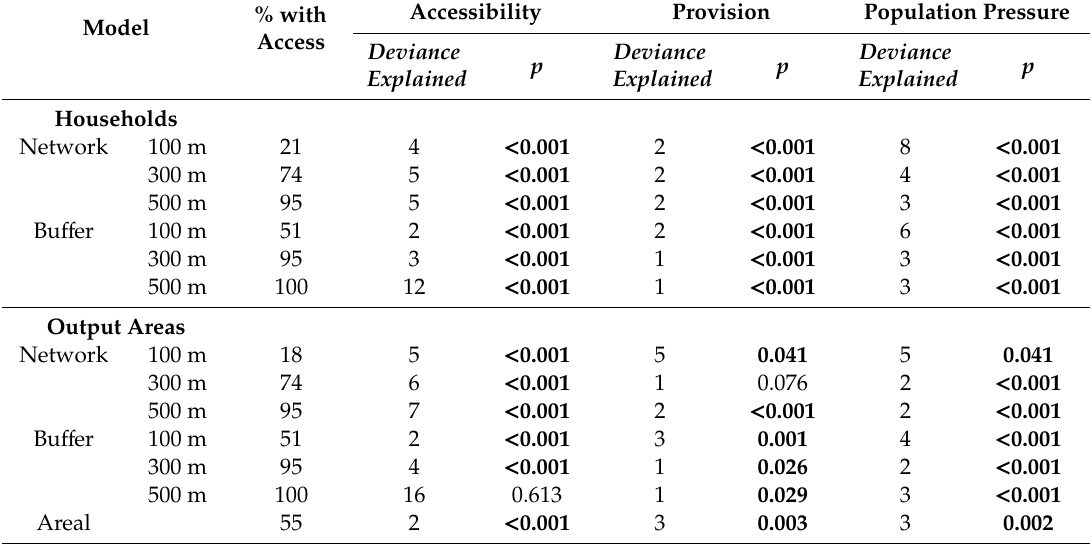
Table 1. Results of ANOVAs testing di ff erences in greenspace accessibility, and provision and population pressure for households / OAs with access to at least one greenspace, by decile of Carstairs Deprivation Index. Deviance explained shown as a percentage. Statistically significant p -values are shown in bold. Proportion of households / OAs with access shown to indicate loss of statistical power in some provision and population pressure analyses (total households n = 243,638; total Output Areas n =